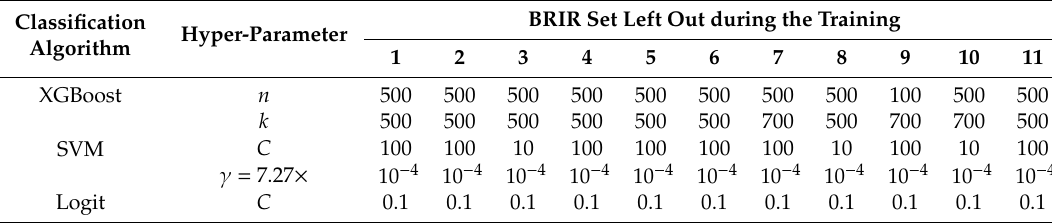
Table A3. Hyper-parameter selected for the eleven models used under the BRIR mismatched test